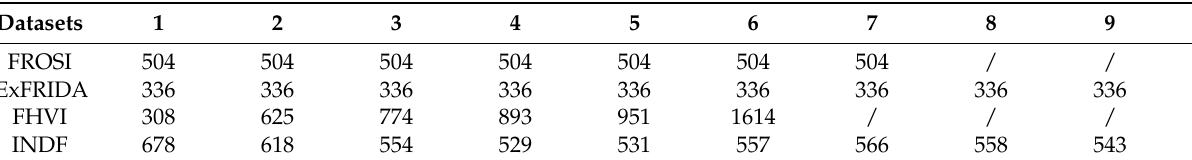
Table 1. The distribution of four datasets with detailed levels and quantities.